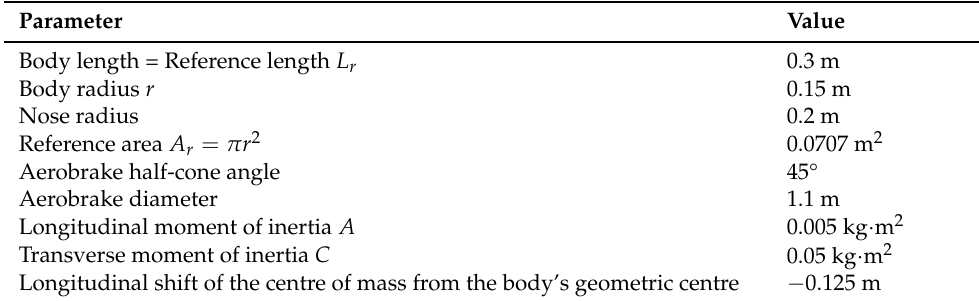
Table 1. Parameters of the example satellite.